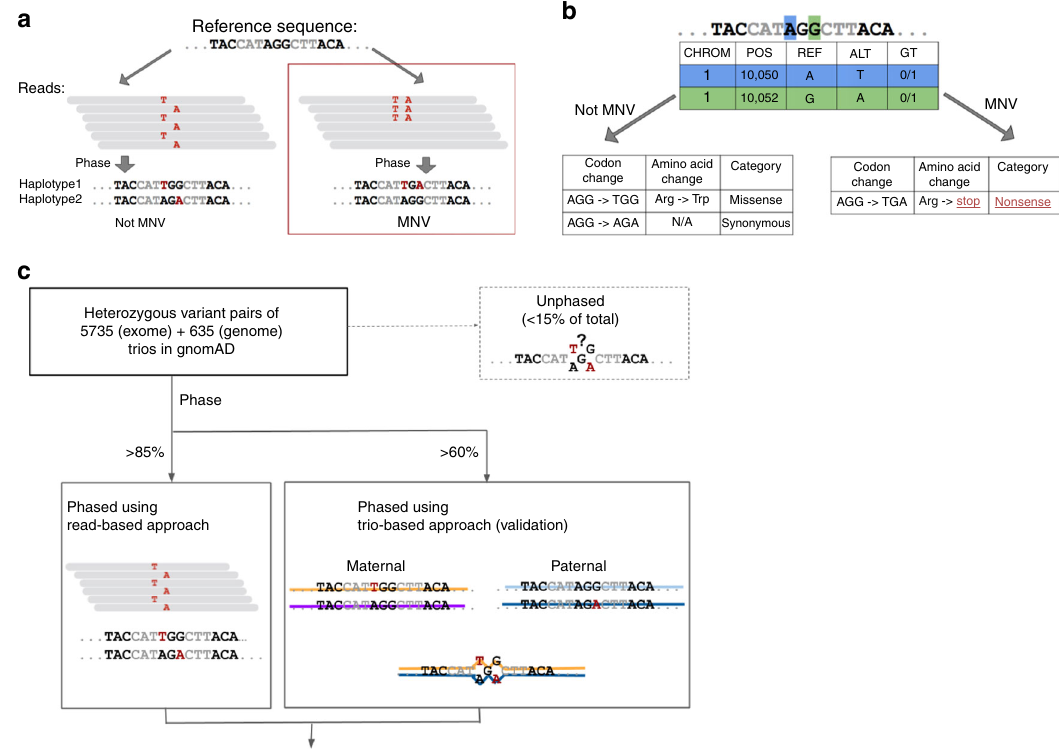
Fig. 1 De fi nition and an example of MNVs, and validation of phasing sensitivity. a De fi nition and an example of an MNV. In this paper, an MNV is de fi ned as two or more nearby variants existing on the same haplotype in the same individual. b Impact of MNVs in coding regions. The amino acid change caused by an MNV can be different from either of the individual single-nucleotide variants, which creates the potential for missannotation of the functional consequence of variants. c Graphical overview of the analysis of phasing sensitivity and speci fi city using trio samples from our gnomAD callset. We identi fi ed all heterozygous variant pairs that pass quality control (see the Methods section) and compared the phase information assigned by read-based phasing with that of trio-based